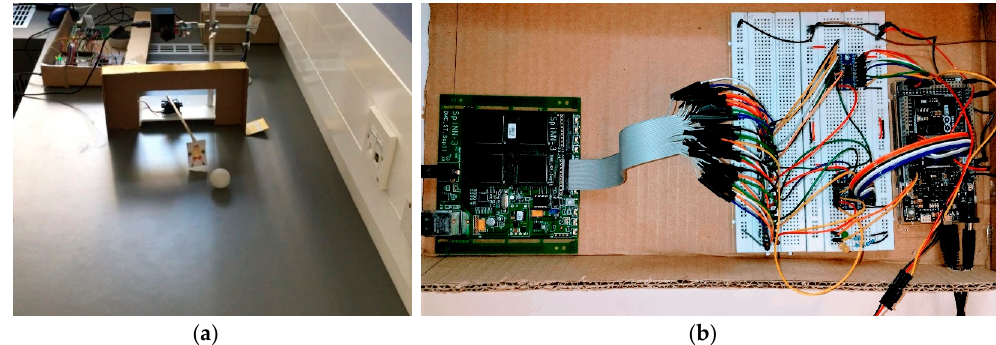
Figure 6. ( a ) Setup of the neuromorphic robotic goalkeeper. ( b ) Connections between the modules. One input/output port is used on SpiNNaker (SpiNN-3) board (shown left) and set in SpiNNakerLink class. Two chips on the protoboard are level shifters (1.8 V to/from 3.3 V), which are used